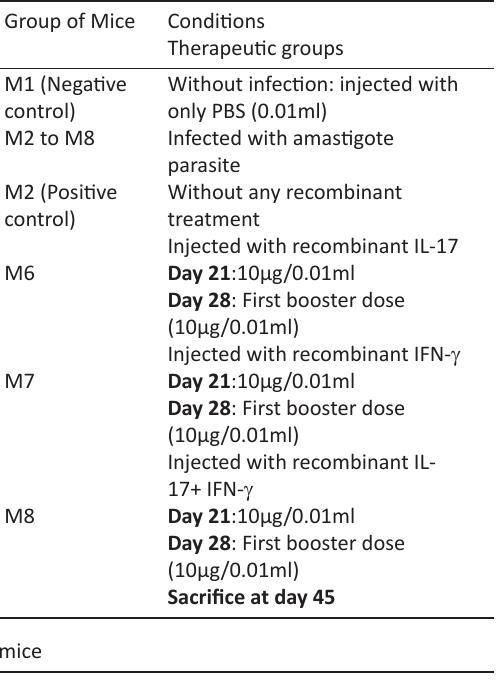
Table 2. Experimental condition of Therapeutic groups of mice Group of Mice Conditions Adjunct therapeutic group